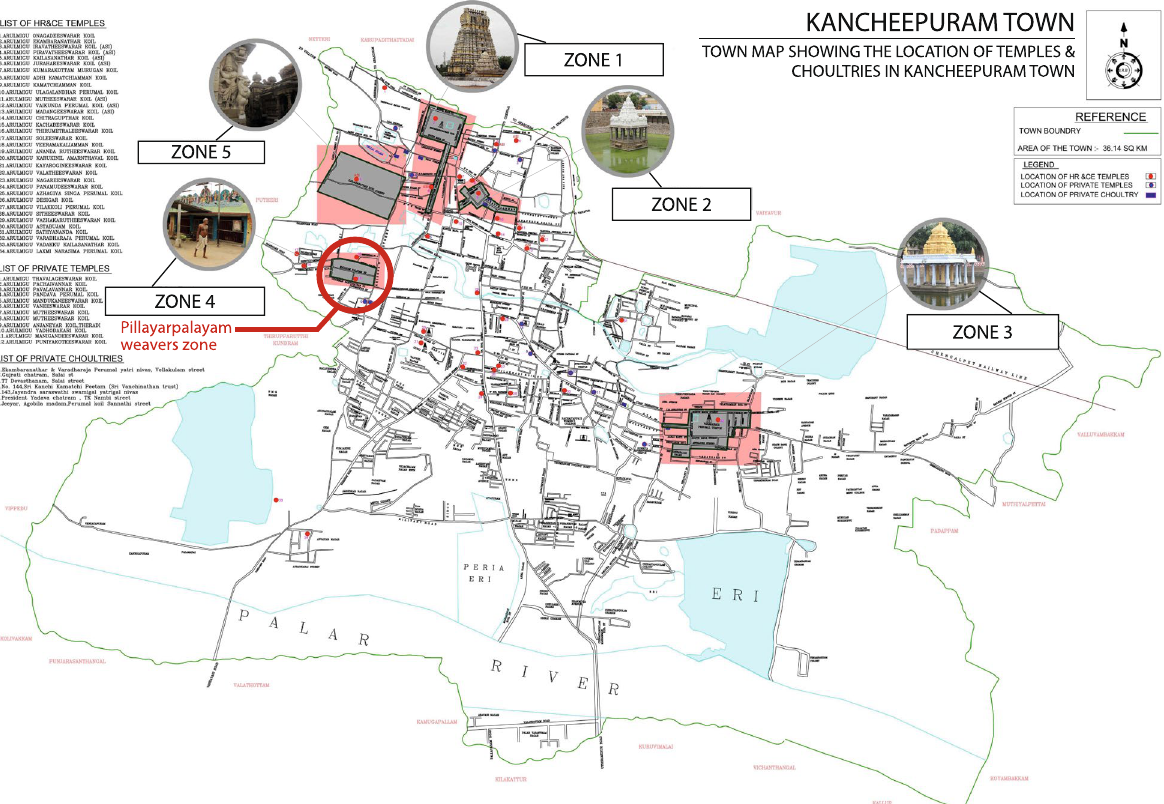
Fig. 2 Map showing the heritage zones of Kanchipuram (Source: Abha Narain Lambah Associates